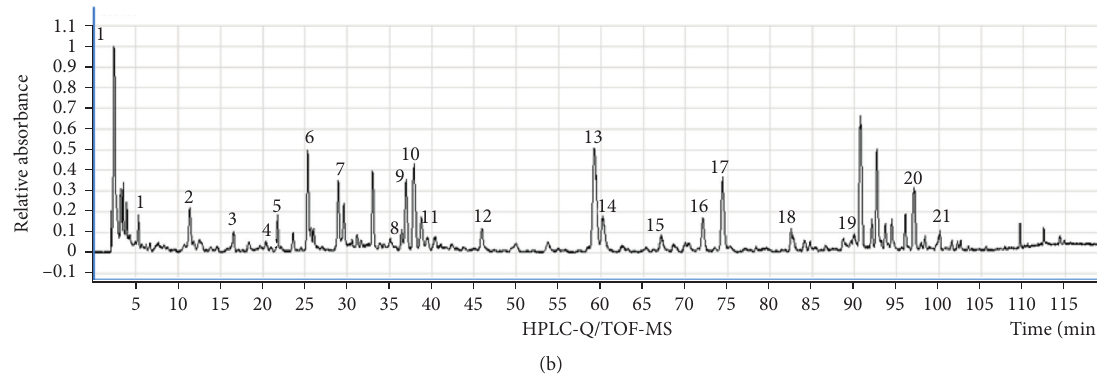
Figure 2: TIC chromatogram in the negative mode of XCQG: (a) HPLC/UV (250 nm); (b) HPLC-Q/TOF-MS.